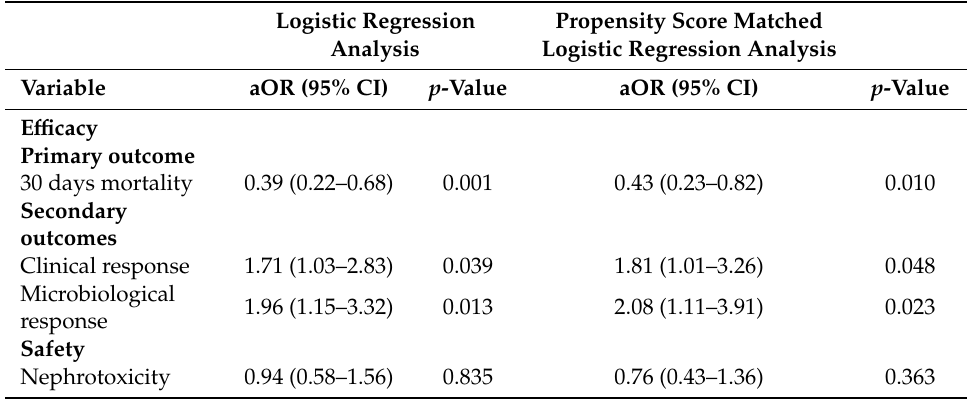
Table 3. Association between colistin-meropenem combination therapy and outcomes for critically ill patients.